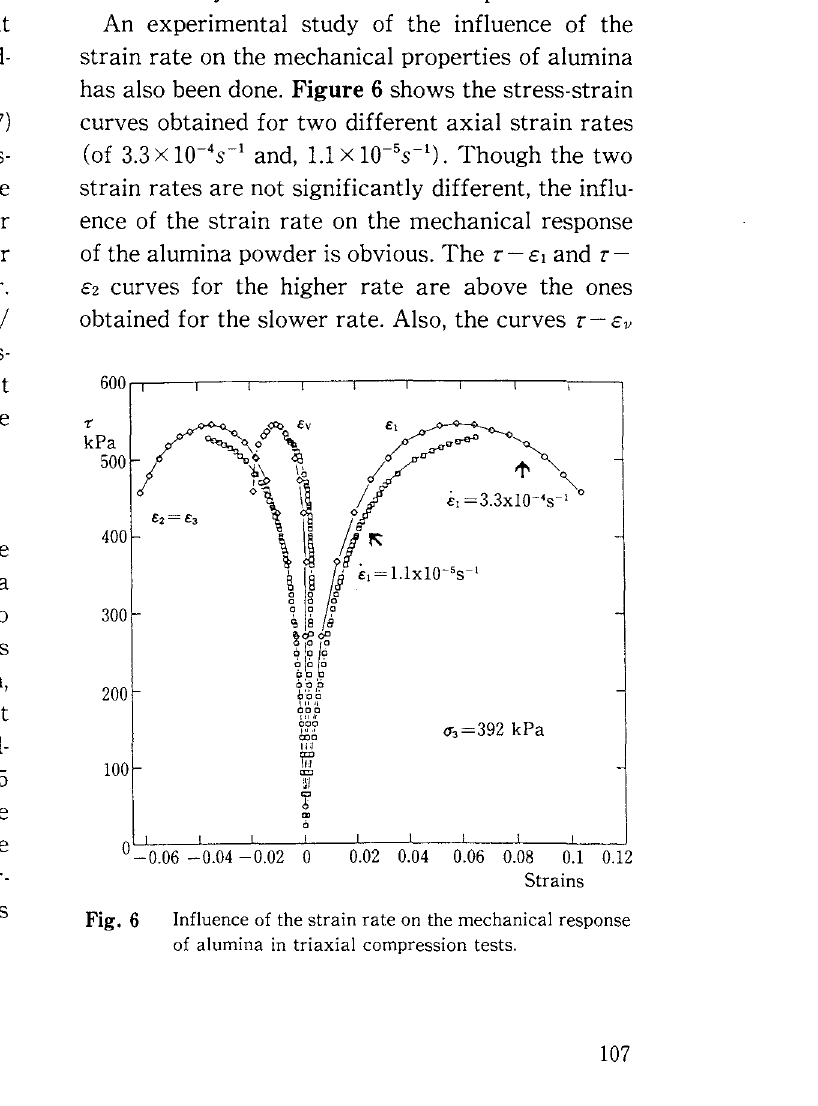
Influence of confining pressure on the volumetric behavior. Arrows show the passage from compres sibility to dilatancy.